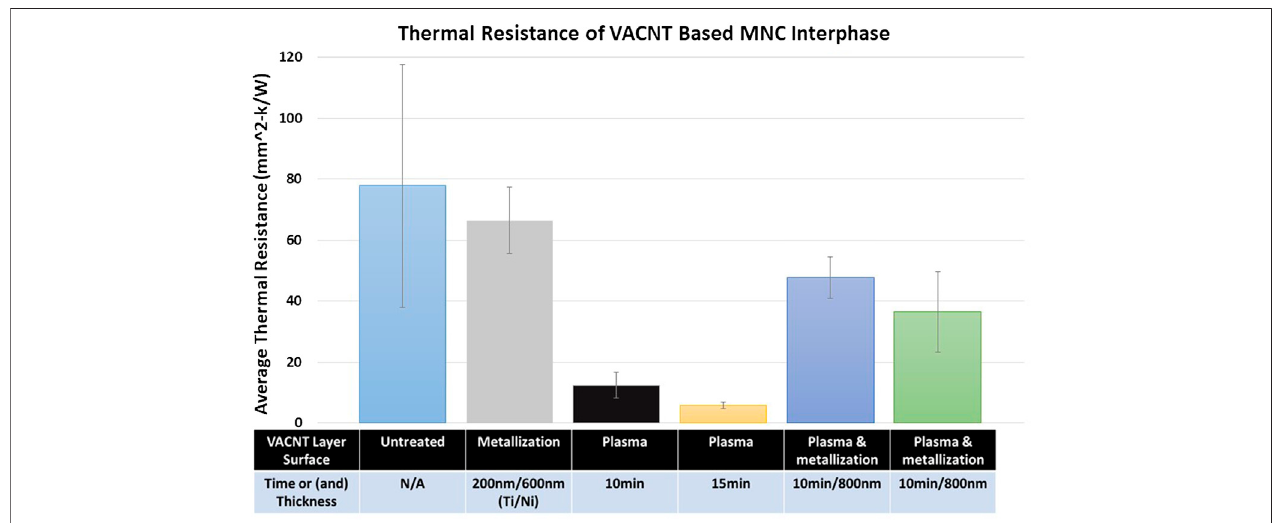
FIGURE 11 | Thermal cycles vs. thermal resistance of VACNT-based MNC as thermal interphase.